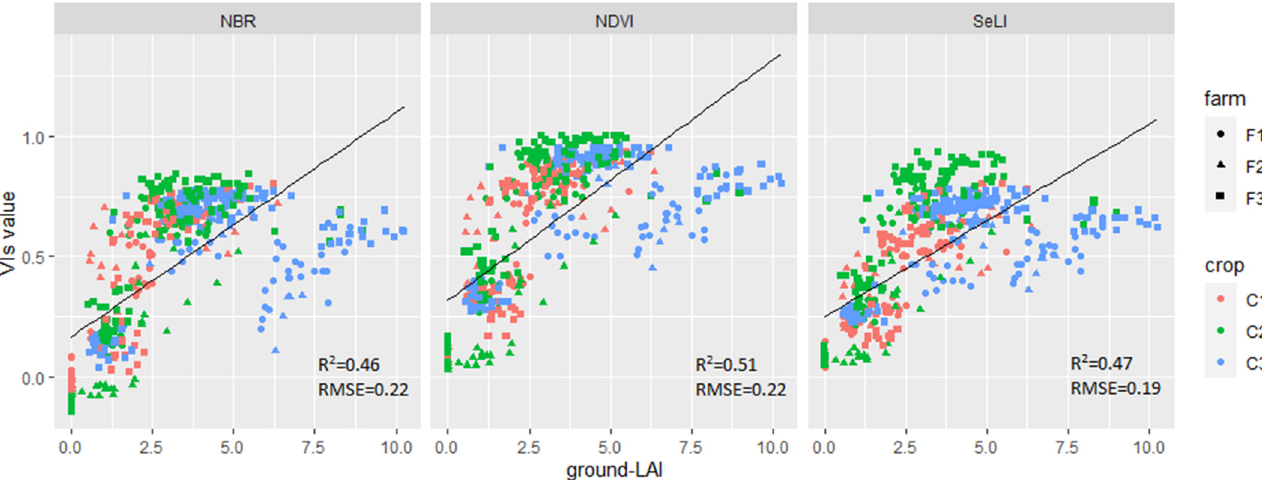
Figure A3. Linear regression between ground-LAI and VIs (NBR, NDVI, and SeLI), according to the Linear function (LM). Dashed line corresponds to the regression curve, while colored dots are the three crops: yellow for winter wheat (C1), blue for maize (C2), and orange for alfalfa (C3). The shapes represent the farms (F1, F2, and